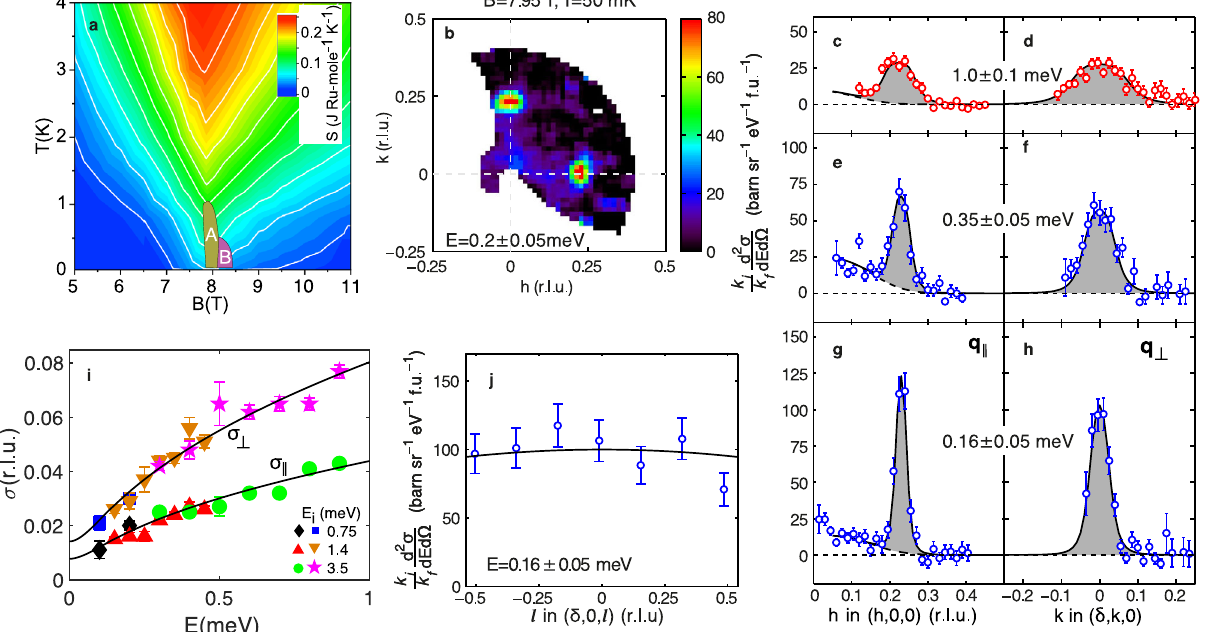
Fig. 1 Quantum criticality and the wavevector-dependence of the magnetic excitations. a Field and temperature dependence of entropy (based on data of Sun et al. 9 ) showing a quantum critical behaviour near B c ≈ 7.95 T and SDW phases A and B 2,5 . b Wavevector-dependence of low-energy (0.2 meV) spin fl uctuations measured at B c showing strong excitations near Q δ (units as c – h ). c – h Q -cuts through Q δ for different energies showing the dispersion of the excitations. The direction of the cut with respect to Q δ is denoted by ∥ and ⊥ . i Energy dependence of the half-width-half-maximum σ of peaks such as those in c – h . Solid line is a fi t to the phenomenological MMP model susceptibility described in the text with the parameters in Table 1. j The 2D nature of the spin fl uctuations is demonstrated by the lack of ℓ -dependence of the response. Data in panels c – h have been integrated over the range − 0.5 < ℓ <